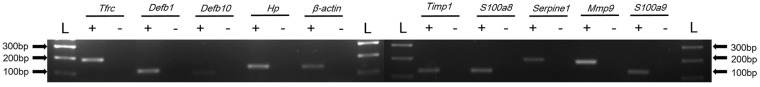
Gel electrophoresis of PCR products of biomarkers genes and β-actin gene.The biomarker genes and β-actin gene expression from bovine whole blood cDNA were confirmed by RT-PCR. A single PCR product was observed with expected size for each biomarker and β-actin gene. No band was observed in the PCR products of negative control without template DNA sample. In the figure (L) indicates 100bp DNA size marker, (+) indicates PCR product with template cDNA, (-) indicates PCR product without cDNA.